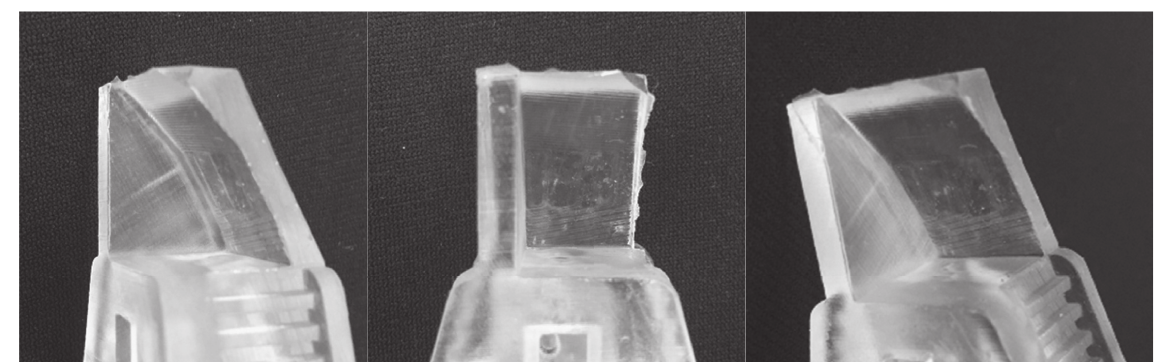
Figure 18: PDMS casting finished